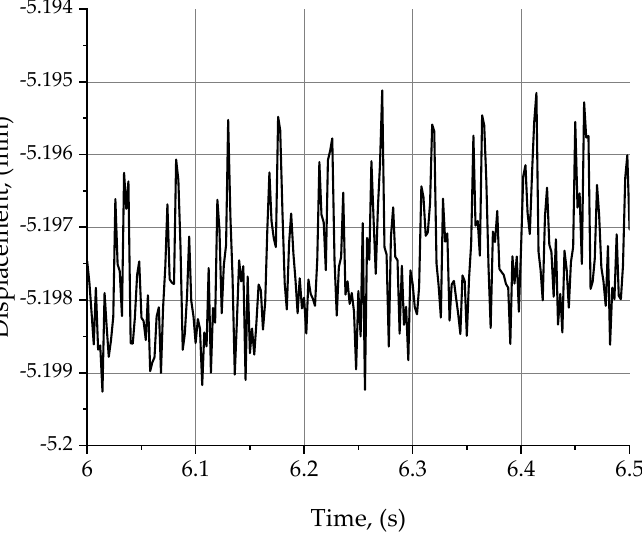
Figure 6. Relative displacement signal plot for v c = 200 m/min, f z = 0.1 mm/tooth, a p = 1 mm, a e = 24 mm, z = 4.